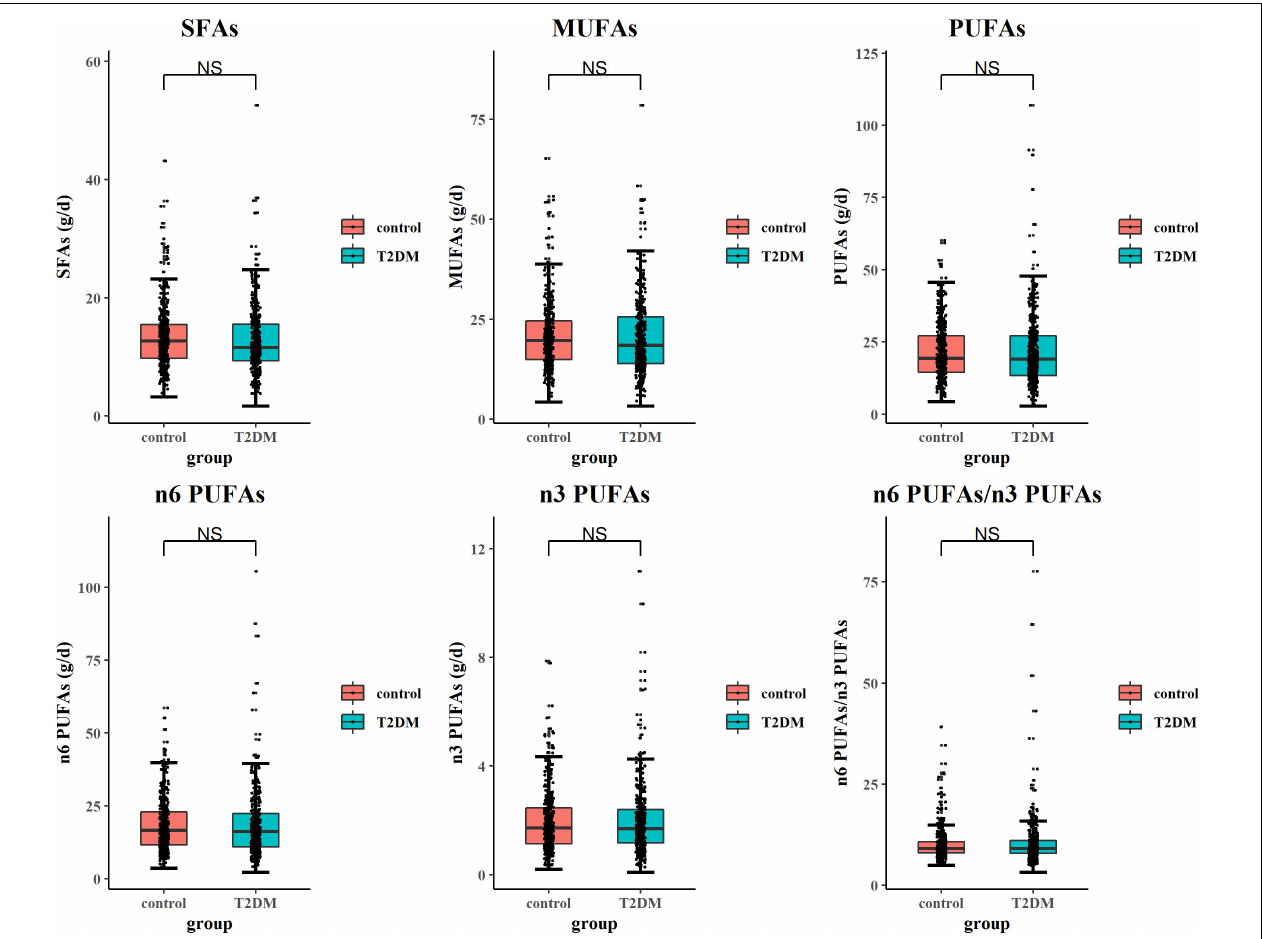
FIGURE 1 | Comparison of dietary fatty acid (FA) intake in type 2 diabetes mellitus (T2DM) and control subjects. The general linear model (GLM) method was applied to analyze the difference in dietary FA intake between groups. Box plots showed each dietary FA intake in subjects with T2DM and control subjects. While comparing daily dietary FA intake, confounding factors including body mass index (BMI), physical activity, hyperlipidemia, cerebrovascular accident (CVA), chronic kidney disease (CKD), eating fish oil supplements, and drinking alcohol were